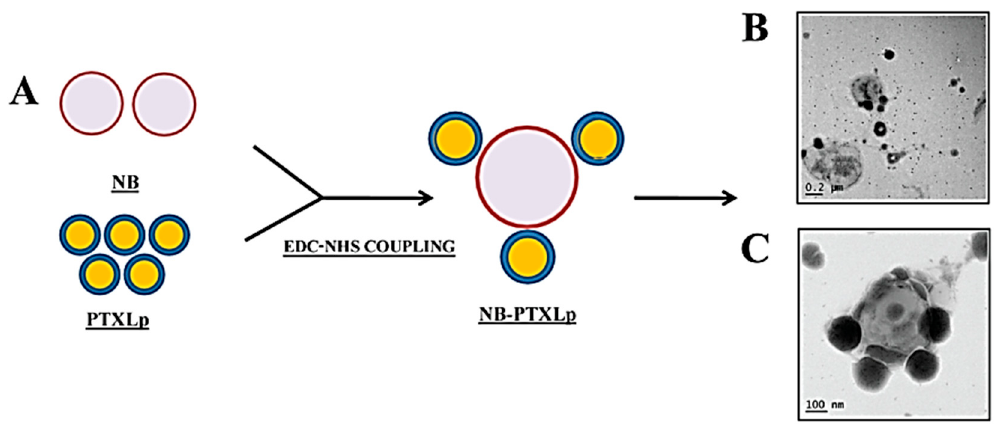
Figure 2. (a) Illustration depicting the formation of NB-PTXLp conjugates by EDC/NHS coupling, (b) ( B ) Transmission electron micrograph of NB-PTXLp conjugate (scale bar—200 nm), ( C ) Transmission Transmission electron micrograph of NB-PTXLp conjugate (scale bar—200 nm), (c) Transmission electron micrograph of NB / PTXLp conjugate (scale bar—100 nm). Reproduced from [234] with electron micrograph of NB/PTXLp conjugate (scale bar—100 nm). Reproduced from [234] with permission from American Chemical Society, permission from American Chemical Society, 2019.